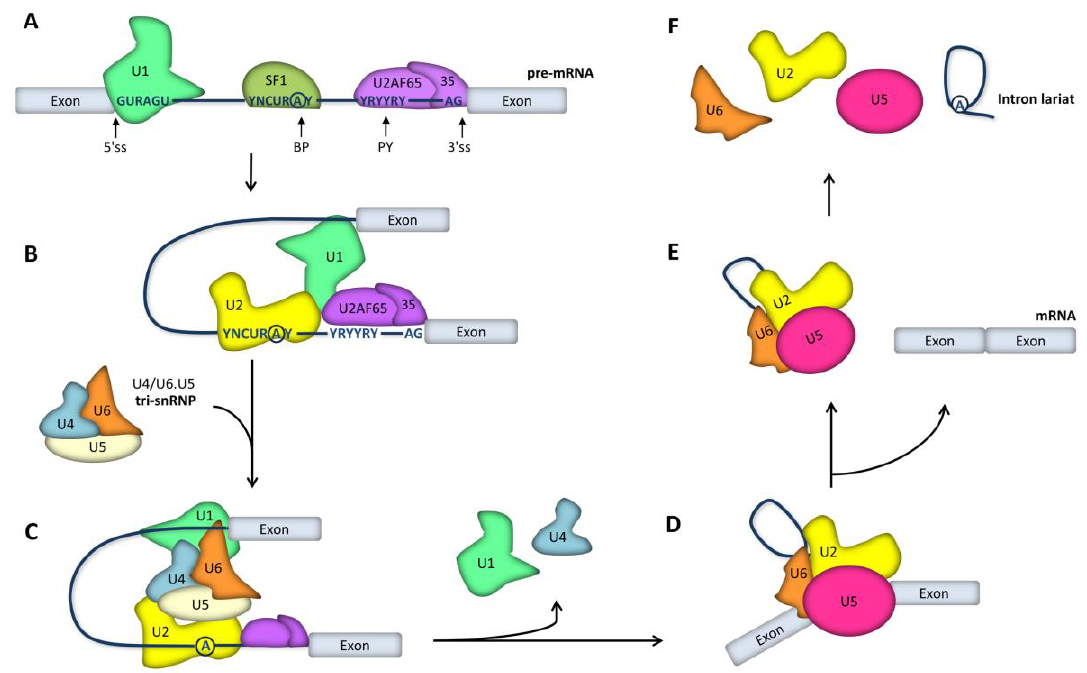
Figure 2. Spliceosome assembly for pre-mRNA splicing. ( A ) Spliceosome assembly is initiated through binding of the U1 snRNP to the 5’ splice site (ss), SF1 to the branch point (BP), U2AF65 to the polypyrimidine tract (PY), and U2AF35 to the 3’ splice site. ( B ) Next, the U2 snRNP displaces SF1 and binds the BP. ( C ) Recruitment of the U4 / U6.U5 tri-snRNP. ( D ) Conformational rearrangements involving the release of the U1 and U4 snRNPs lead to catalytic activation. ( E ) Ligated exons are released from the spliceosome, and the remaining snRNPs persist, associated with the intron lariat. ( F ) Subsequently, snRNPs dissociate from the excised intron.